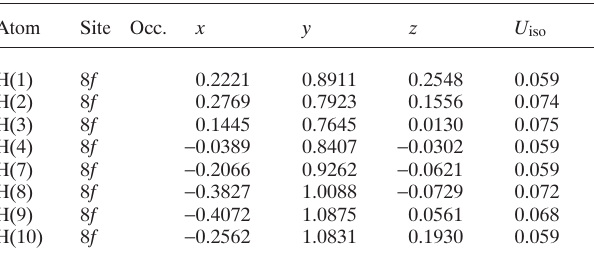
Table 2. Atomic coordinates and displacement parameters (in Å 2 )